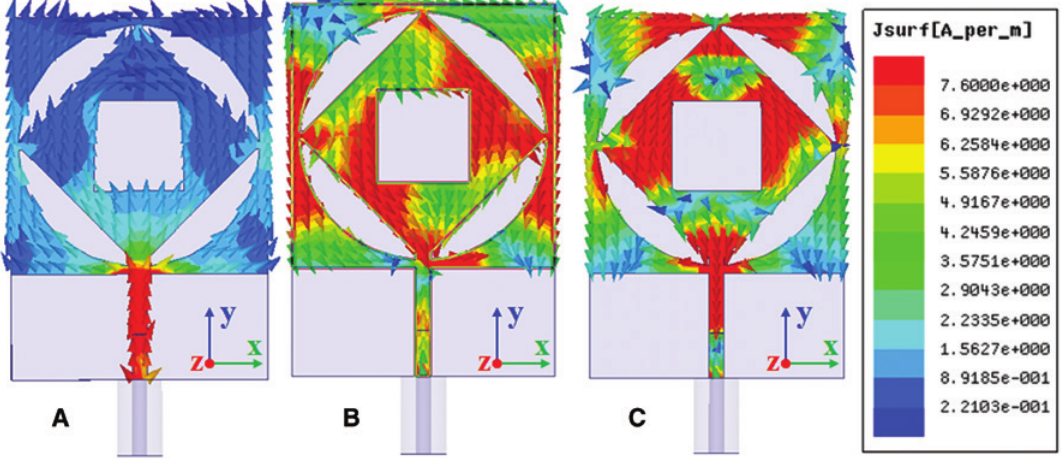
Figure 6: Simulated surface current distributions at (A) 0.8 GHz, (B) 3.35 GHz, and (C) 8.0